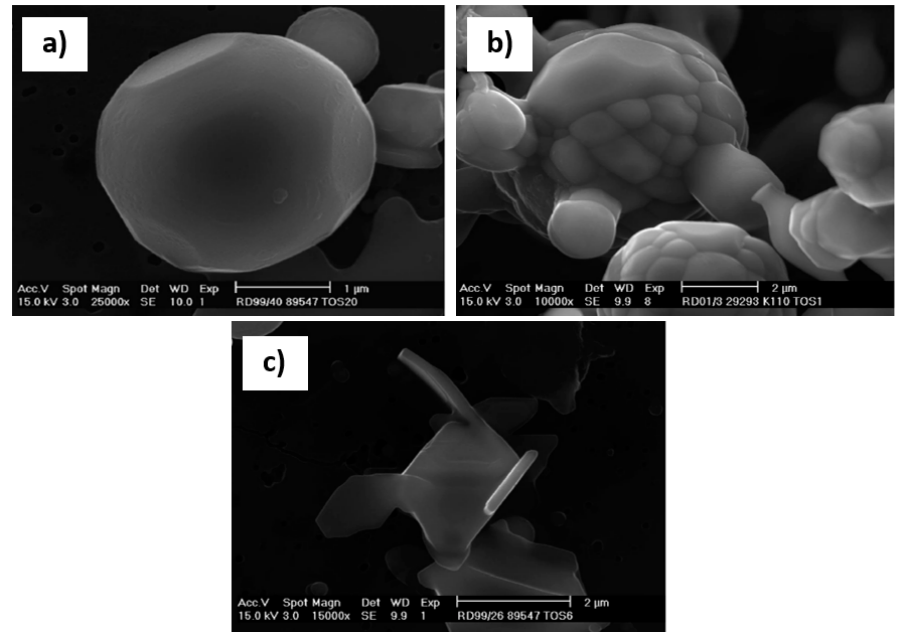
Figure 1. Different morphologies (( a ) spherical, ( b ) agglomerated and ( c ) plate-like overgrowth) of alumina as extracted from a low carbon Al killed steel as mentioned in Dekkers et al. [60]. Copyright 2003, Springer Nature.